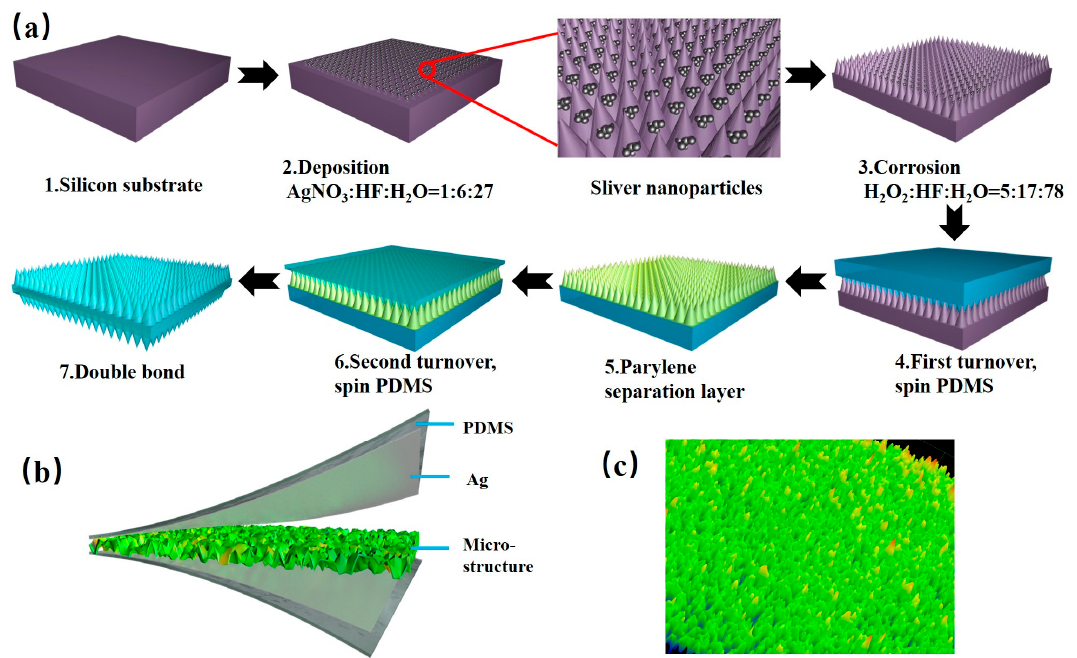
Figure 3. Fabrication process of the dielectric layer. ( a ) Main processes of microstructure manufacture, deposition, corrosion, first turnover, and second turnover. ( b ) Illustration of the capacitive pressure sensor based on a microstructured electrode. ( c ) Characterized 3D microstructure surfaces under laser scanning microscope (LSM). PDMS—polydimethylsiloxane.